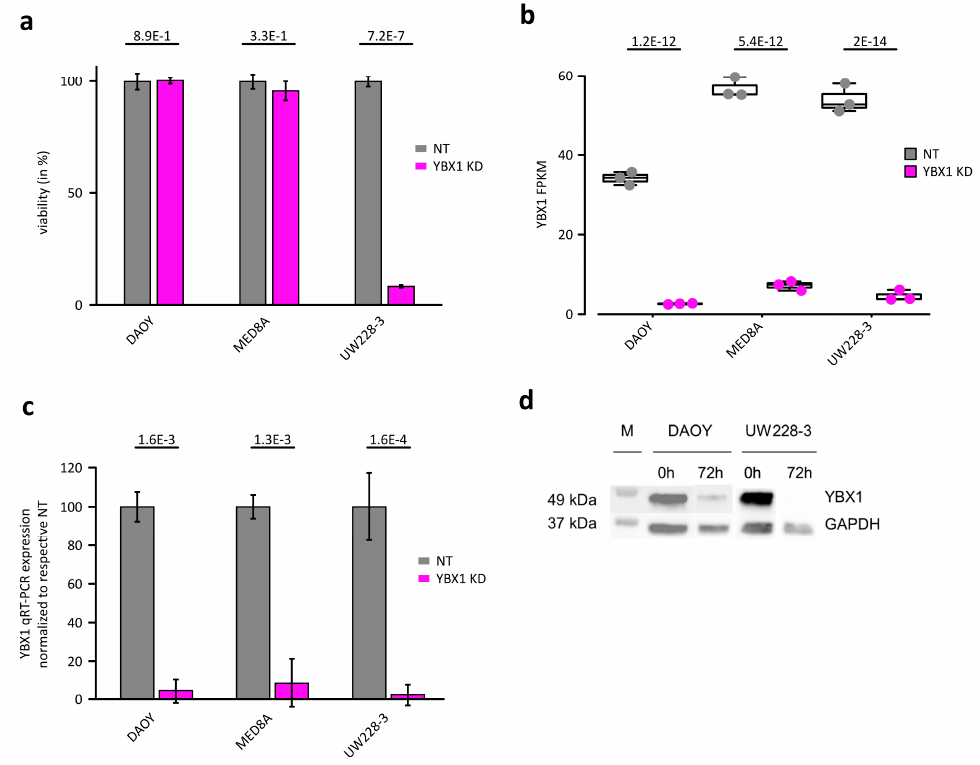
Figure A1. ( a ) Cell viability of DAOY, MED08A and UW228-3 upon YBX1 KD after 96 h. Significance was calculated using a t-test. ( b ) YBX1 expression as normalized FPKM taken from RNA-Seq data. Differential expression analysis was performed with edgeR, and FDR values between NT and YBX1 KD are reported. ( c ) YBX1 expression measured by qRT-PCR each normalized against 18S rRNA, then normalized against the respective cell line NT average. Significance was calculated using an unpaired two-sided t-test. ( d ) Western blot of YBX1 before and 72 h after siRNA-mediated knockdown in cell lines DAOY and UW228-3.